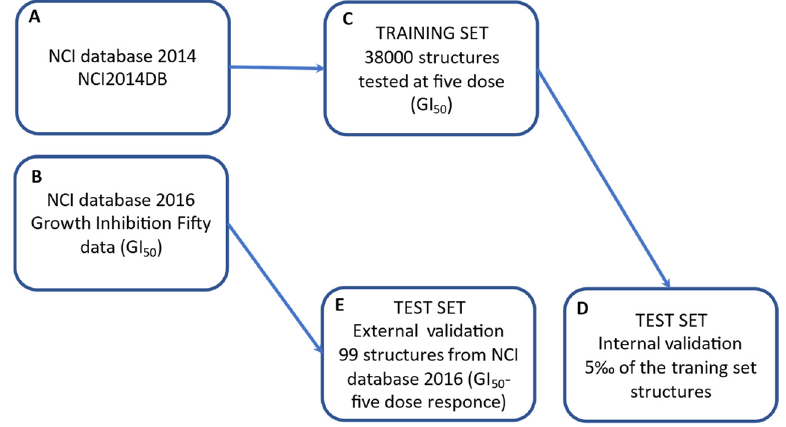
Figure 2. NCI selection data used in the AAP tool: compounds screened in five-dose assay and published until 2014 were used as training set; the 5‰ of these structures was used for the internal validation of the protocol (panels A , C , D ); those structures screened in five-dose assay and pub- lished until 2016 were used as test set to evaluate the predictive performance of the entire protocol (panels B,E ).